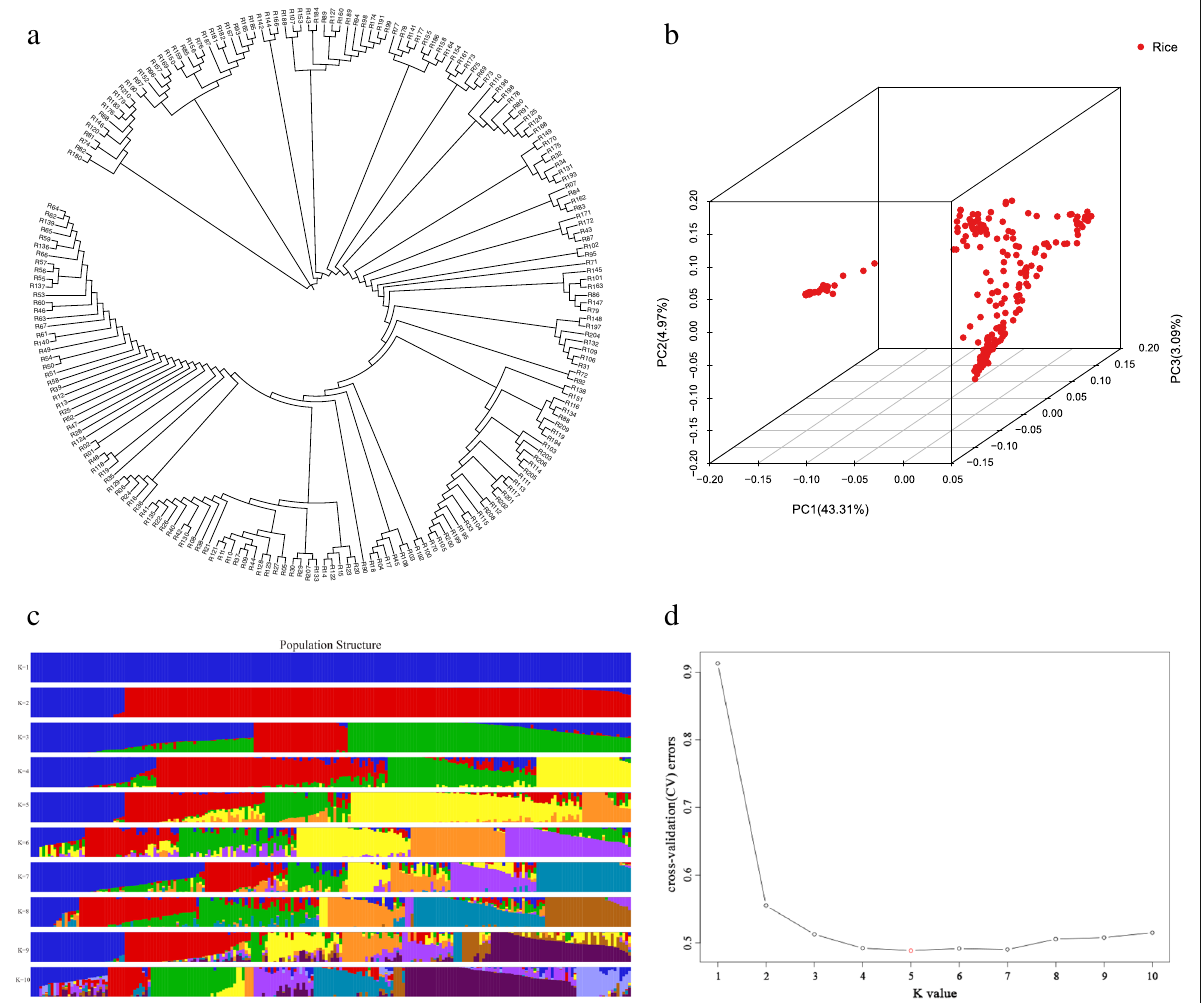
Fig. 3 Genetic evolution of natural populations of indica and japonica rice. a Phylogenetic tree, each branch is a rice germplasm. b Principal component analysis on 2.12 million SNPs of 209 rice accession. PC 1 and PC 2 refer to the first and second principal components, respectively. The numbers in parentheses refer to the proportion of variance explained by the corresponding axes. Red points represent each variety in 209 rice accession. Each point represented a rice germplasm accession. The closer the distance between the points, the closer the relationship was. c Cluster analysis results of population genotypes, in which each color represents a group and each row represents a group value. d Cross validation error rate for each k value. Among them, K is the smallest when k is